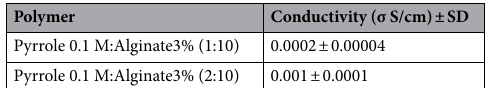
Table 1. Conductivity measurements of PPy–Alg composites.